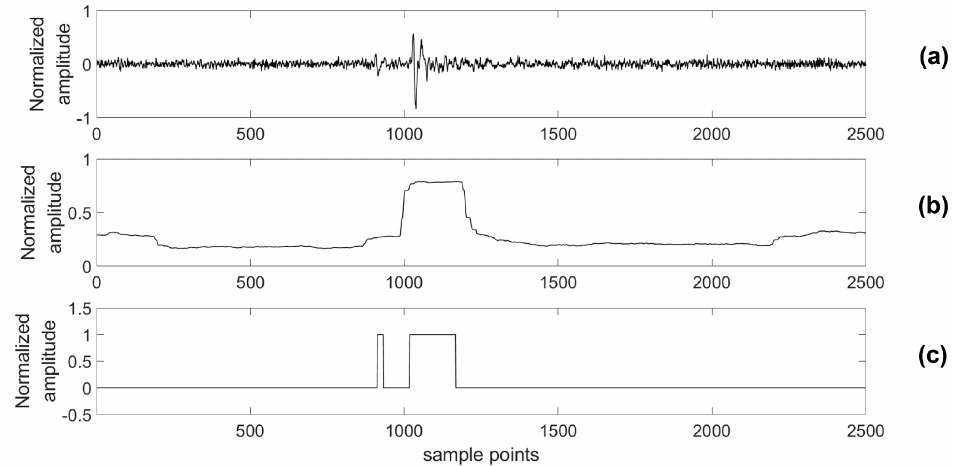
Figure 20. Original data and its classification results. ( a ) The original data; ( b ) The classification results of the STA/LTA algorithm; ( c ) The classification results of proposed algorithm.